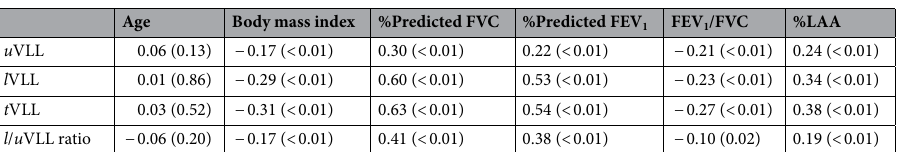
Table 3. Correlations between vertical lung length and clinical factors. Data expressed as Pearson’s correlation coefficient ( p value). FEV 1 forced expiratory volume in 1s, FVC forced vital capacity, %LAA percentage low- attenuation